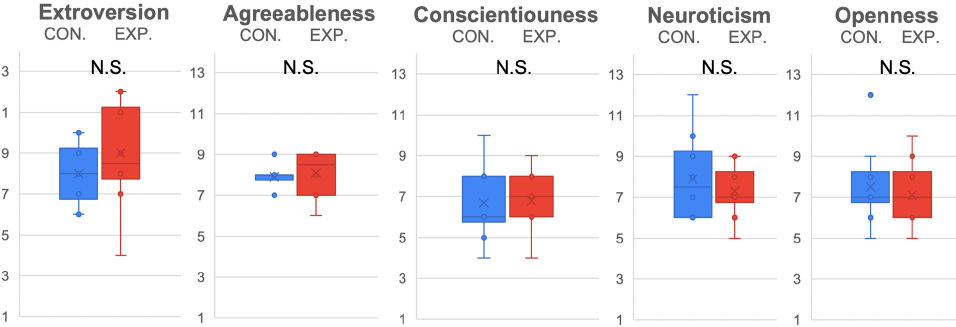
Figure 8. Personality evaluation of ERICA with Big Five by female subjects. * indicates the found significant difference, while N.S. indicates there is no significant difference.